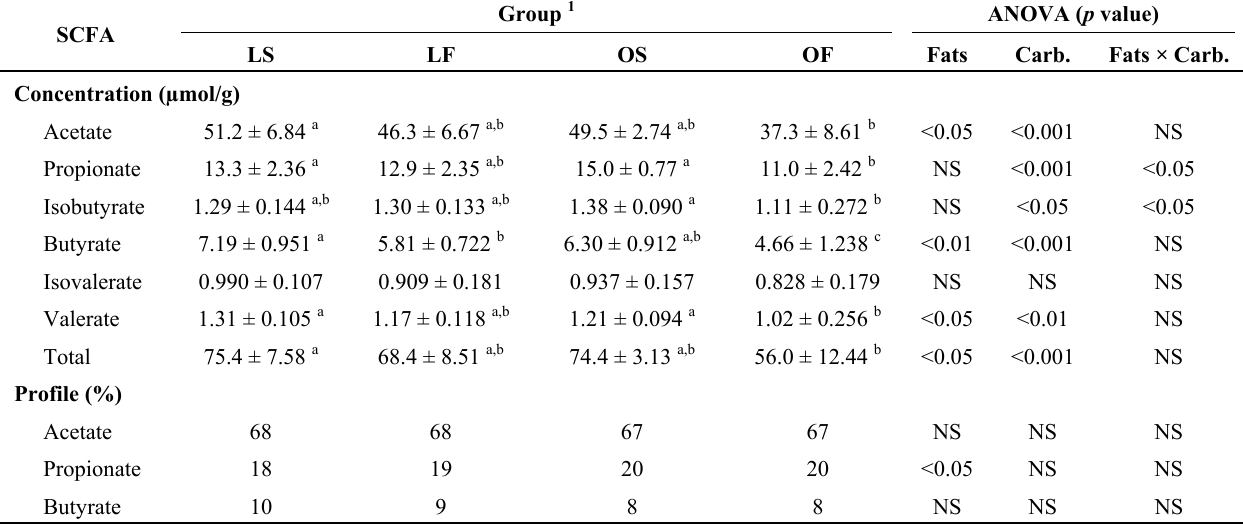
Table 3. Short-chain fatty acid (SCFA) content in the caecal digesta of rats fed high-fat diets differing according to the types of fats and